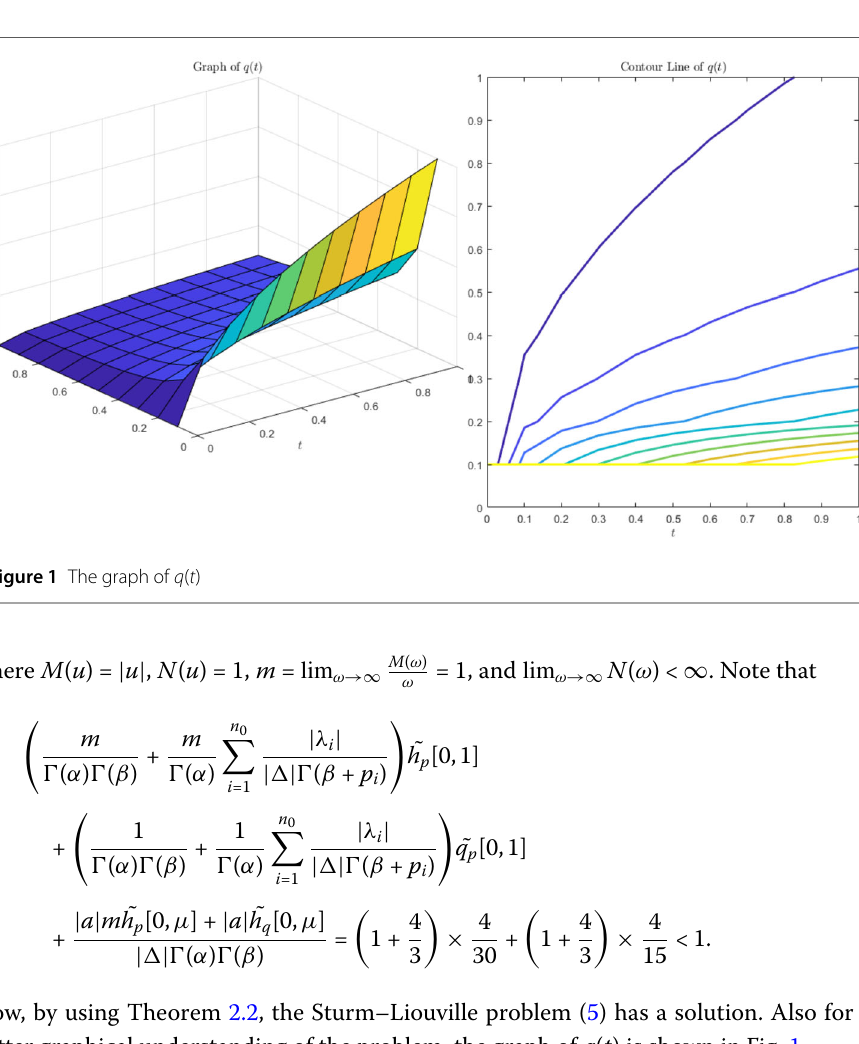
where M ( u ) = | u | , N ( u ) = 1, m = lim ω →∞ M ( ω )